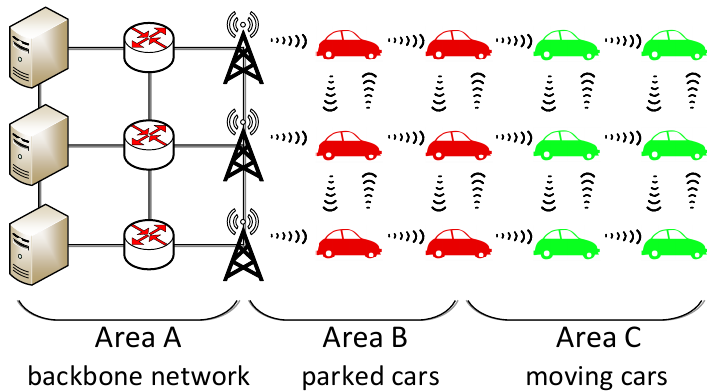
Figure 7. A service scenario example of Internet of Vehicles (IoV) that contains heterogeneous environments.